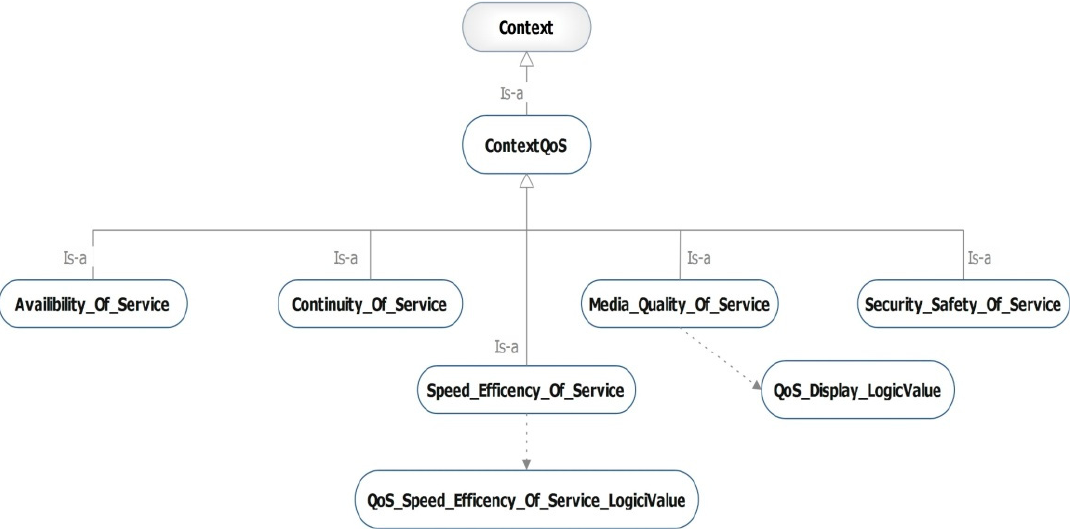
Figure 6. QoS context sub ‐ ontology.